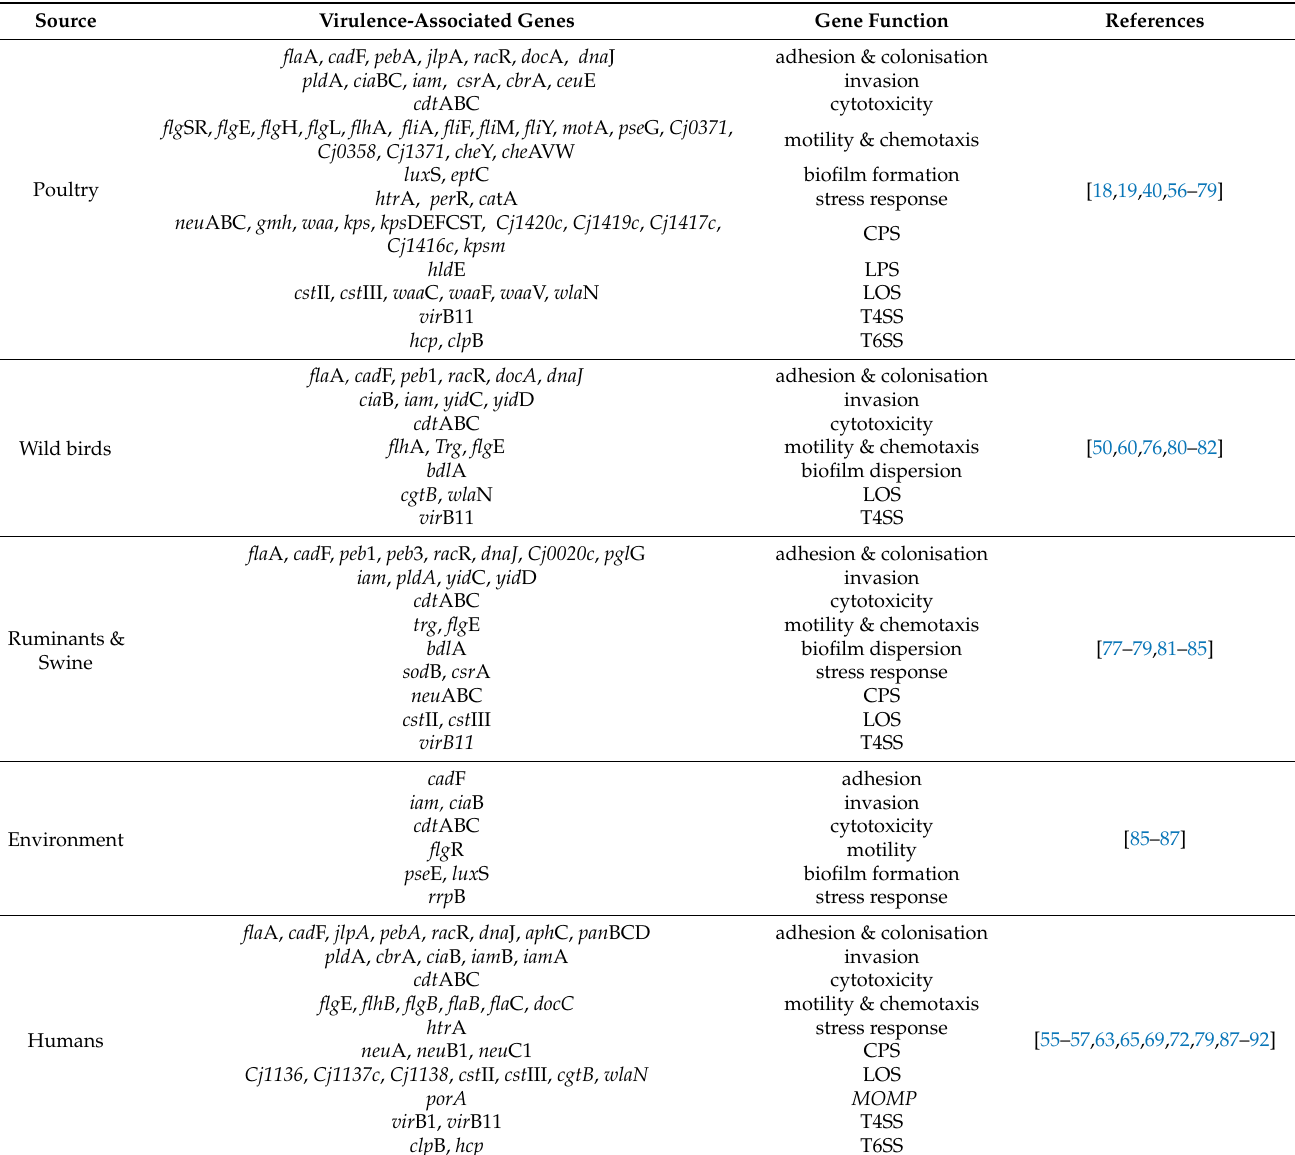
Table 1. Highly prevalent virulence-associated genes detected in Campylobacter spp. isolated from various